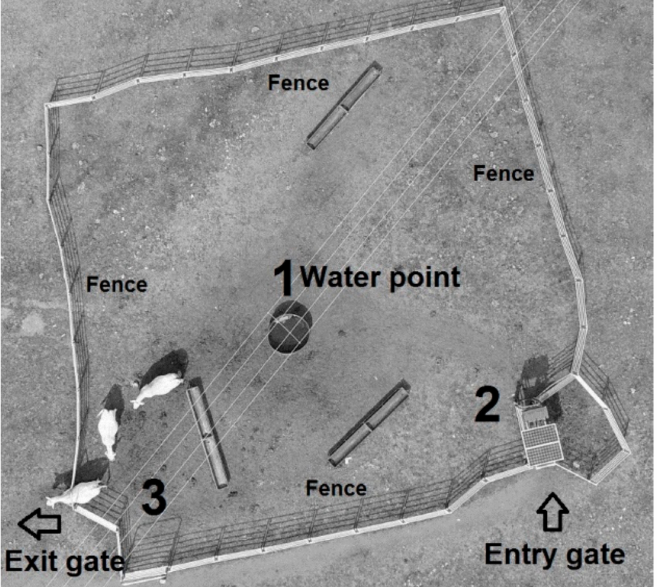
Figure 1. Aerial photo (drone) showing the setup of the walk-over-weighing system. Numbers indicate ( 1 ) water point; ( 2 ) walk-over-weighing scale deployed at the entry gate; and ( 3 ) exit gate. Both entry and exit gates enabled cattle to walk through the unidirectional spear gates to access the water